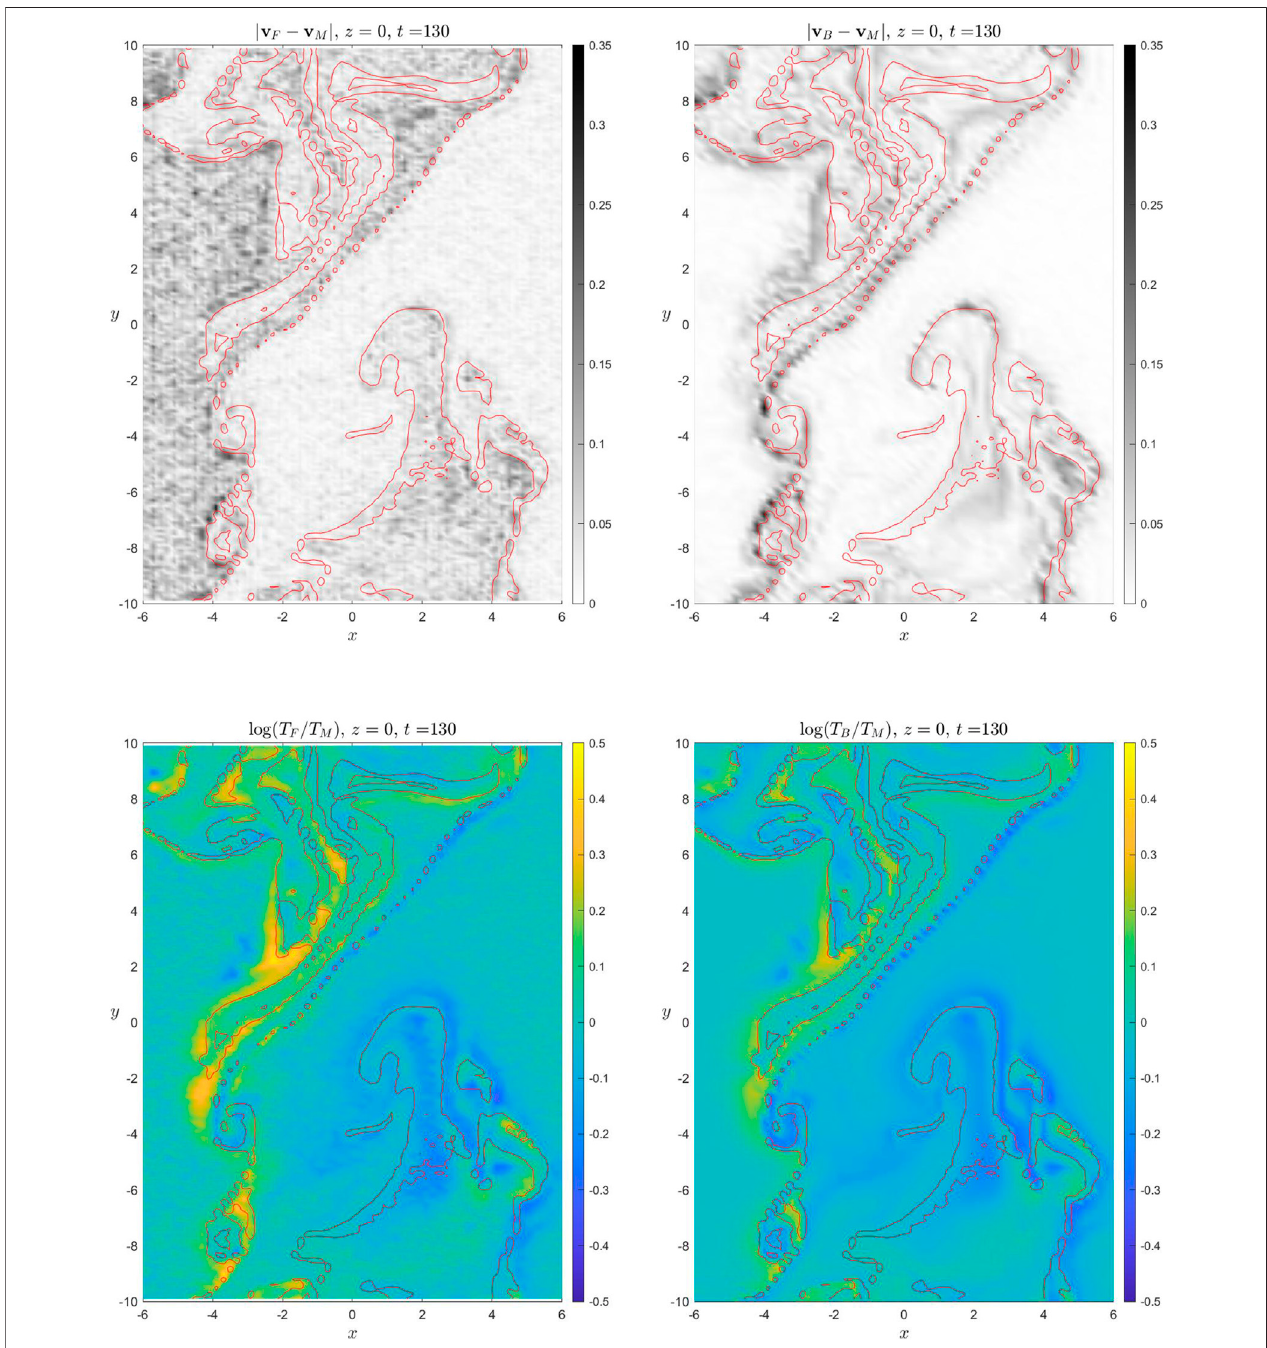
FIGURE 4 | The color index represents the deviation between the bulk velocity (top) and temperature (bottom) from MHD simulation and test particles for the symmetric case at t (cid:1) 130. The left and right panels show the forward tracing and backward tracing, respectively. The red lines are the contour lines of r M (cid:1) 0.5.